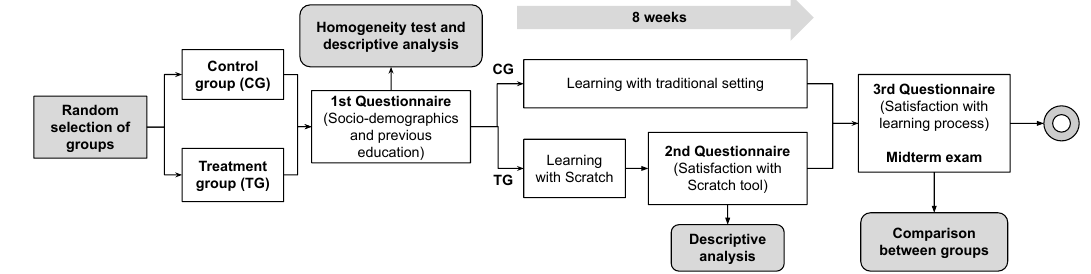
Figure 1. Workflow followed in this research